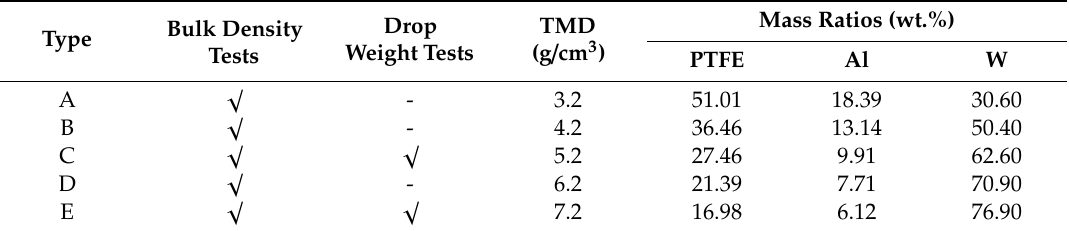
Table 1. Theoretical maximum densities (TMDs) and corresponding component mass ratios of PTFE / Al / W for multiple